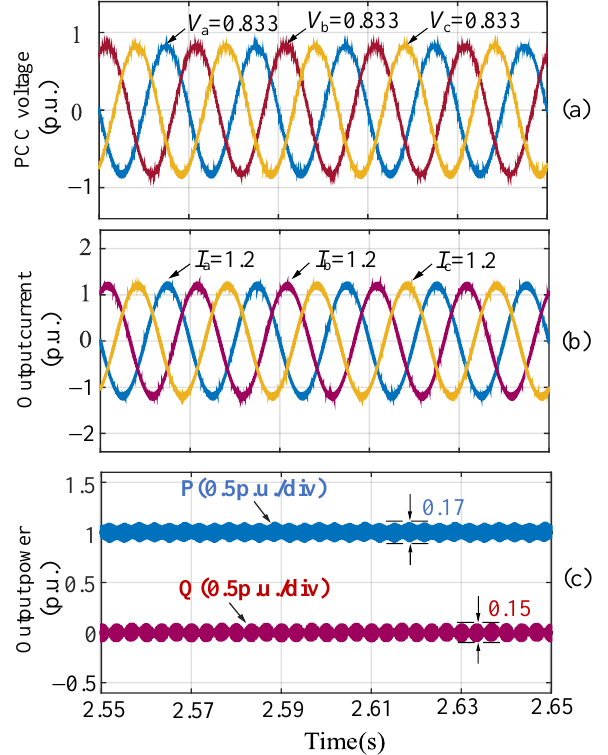
Figure 12. Simulation results of the modified topology, when V b drops to 0.5 p.u. ( a ) Output voltage at PCC 1 ; ( b ) output current; ( c ) output active power and reactive power.